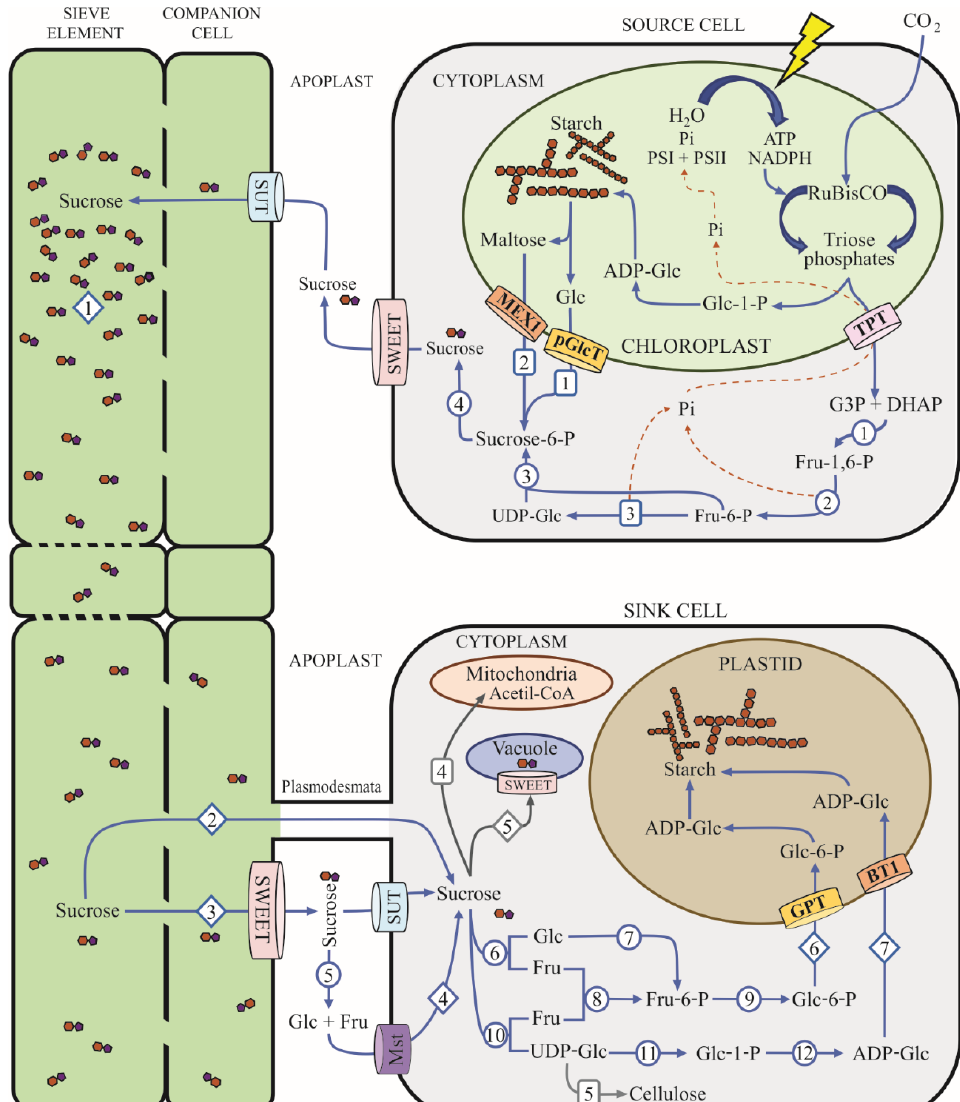
Figure 1. Common plant pathways of carbon assimilation and partitioning from source to sink tissues. This diagram shows a current model for organic carbon biosynthesis and translocation from photosynthetic to heterotrophic cells (based on previous models by MacNeill et al., 2017 and López-González et al., 2019 [51,52]). Blue arrows trace the current carbon flow routes, the discontinued orange arrows show Pi flux, and the colored barrels designate carbohydrate transporters. Enzymes are indicated in numbered circles as: (1) Fructose 1,6-bisphosphate aldolase (EC 4.1.2.13); (2) FBPase (EC 3.1.3.11); (3) SPS (EC 2.4.1.14); (4) SPP (EC 3.1.3.24); (5) Apoplastic invertase (EC 3.2.1.26); (6) Neutral (cytoplasmic) invertase; (7) Hexokinase (EC 2.7.1.1); (8) Fructokinase (EC 2.7.1.4); (9) Phosphoglucoisomerase (EC 5.3.1.9); (10) SuSy (EC 2.4.1.13); (11) UDPase (EC 2.7.7.9); (12) ADP-glucose pyrophosphorylase (EC 2.7.7.27) [52]. The numbers in rounded rectangles denote specific metabolic pathways: (1) and (2) starch-derived carbohydrates translocated to cytoplasm by Maltose Excess Protein (MEX1; ([52,53])) or Plastidic Glucose Translocator (pGlcT; [52,54]), as possible precursors for Suc biosynthesis; (3) synthesis of UDP-Glucose from Fructose-6-P; (4) Suc catabolism for energy metabolism; (5) Cellulose biosynthesis. Diamonds indicate potential carbon fluxes as: (1) Suc mass flow from source to sink tissues through the phloem; (2) symplastic transport of Suc from phloem to the sink cells; (3) apoplastic transport of Suc from the phloem to sink cells; (4) Monosaccharides transported from the apoplast to sink cells by Monosaccharide transporters (Mst), as potential substrates for Suc biosynthesis; (5) Vacuole import of Suc for transient storage; 6 and (7) Glc-6-P and ADP-Glc imported into plastids by specific transporters (GPT; Glc-6-P/Pi translocator and BT1; Adenine nucleotide transporter Brittle1, respectively, (see [51,52,54] for review) and directed to starch biosynthesis.